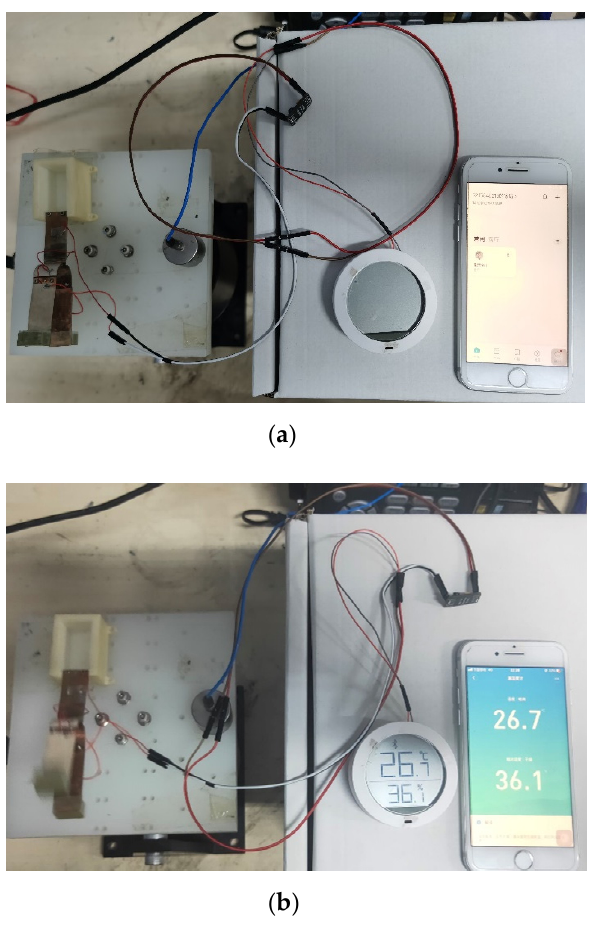
Figure 14. Pedometer powered by the tuning fork energy harvester. ( a ) The tuning fork energy harvester not working; ( b ) the tuning fork energy harvester working.